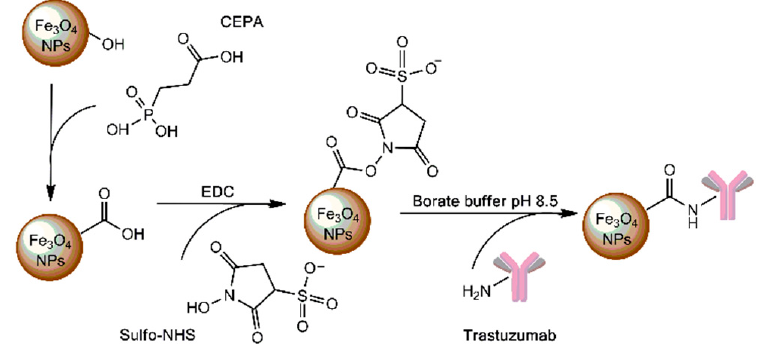
Figure 3. Scheme of the Fe 3 O 4 nanoparticles surface functionalization with 3-phosphonopropionic acid (CEPA) and trastuzumab molecules.